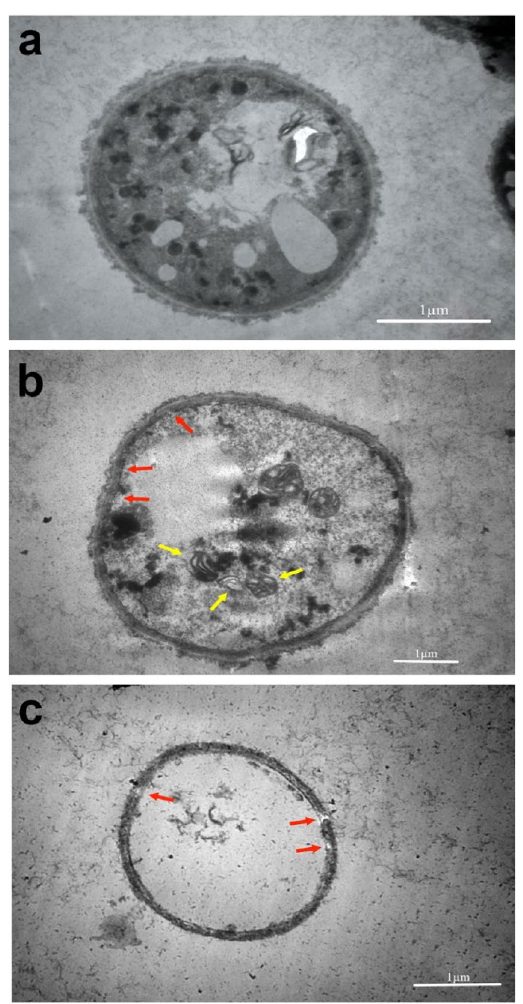
Figure 4. Transmission electron microscopy of T. rubrum cells in non-treated ( a ) and CAP-treated ( B - C ) samples. The images were taken from control samples ( a ), and 210 s CAP treated samples after 24 h ( b ) and 96 h ( c ) incubations. A typical cell is represented by control sample. There are noticeable changes as cytoplasmic degradations, deformation of the cells and intracellular organs in B especially mitochondria (yellow arrows) and deformation of cell membrane (red arrows) while the severity of cell damages are obvious in C as breaking down of intracellular organelles into larger vesicles, deformation of cells and the membrane became more detached from the fungal cell